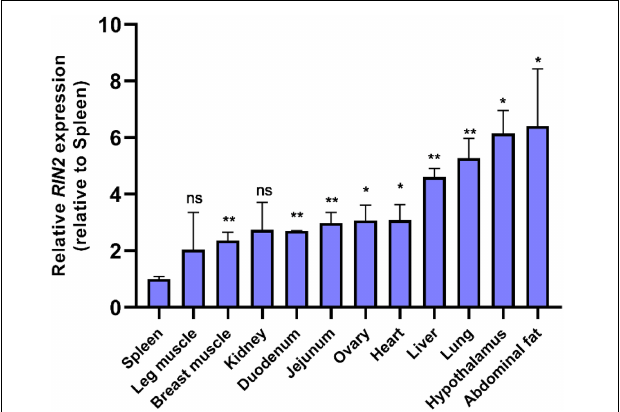
FIGURE 5 | Expression of RIN2 mRNA in different tissues detected by qPCR ( n = 4 samples of each tissue). ns, no significant difference ( P > 0.05); ∗ , significant difference ( P < 0.05); **, very significant difference ( P < 0.01).